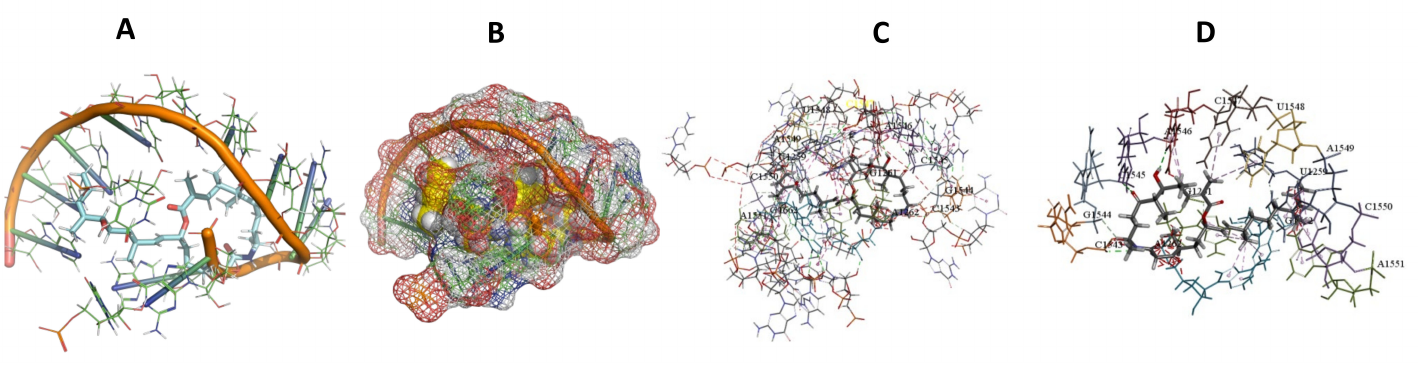
Figure 9. L. major + Angiolam. ( A ): Best binding pose and nucleotides involved. ( B ): Schematic binding pocket. ( C ): shows the Nucleotides component that re involved in binding. ( D ): Shows the main bonds involved between the compound and the nucleotide